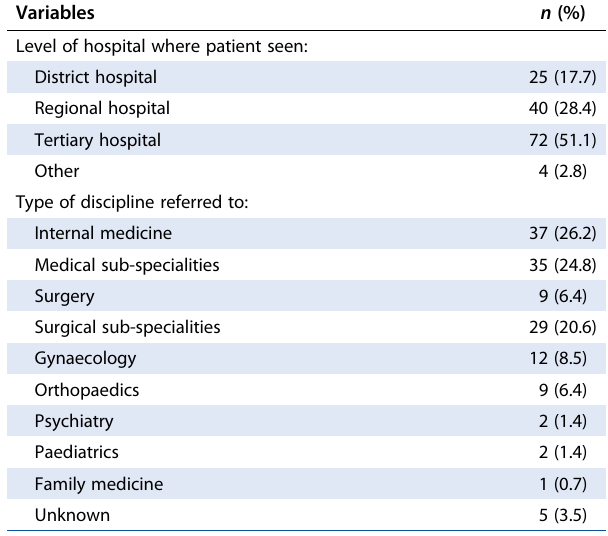
Table 2: Characteristics of referral hospitals ( n = 141)